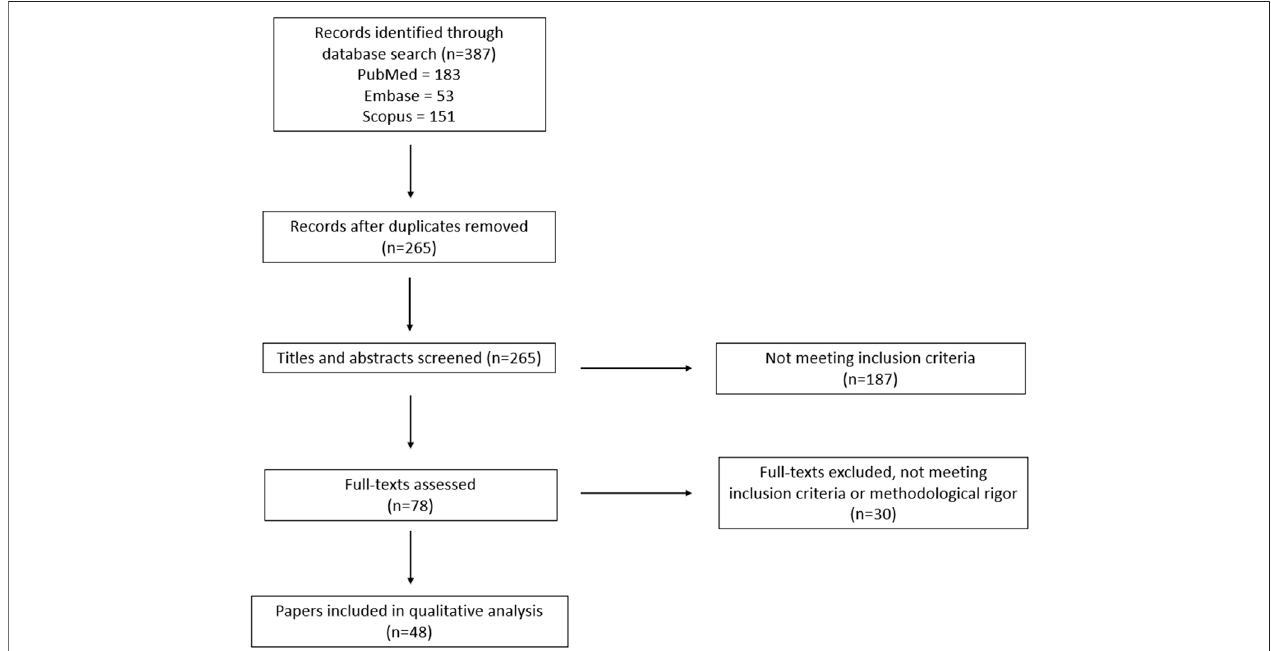
FIGURE 1 | PRISMA fl owchart outlining the protocol used in this systematic